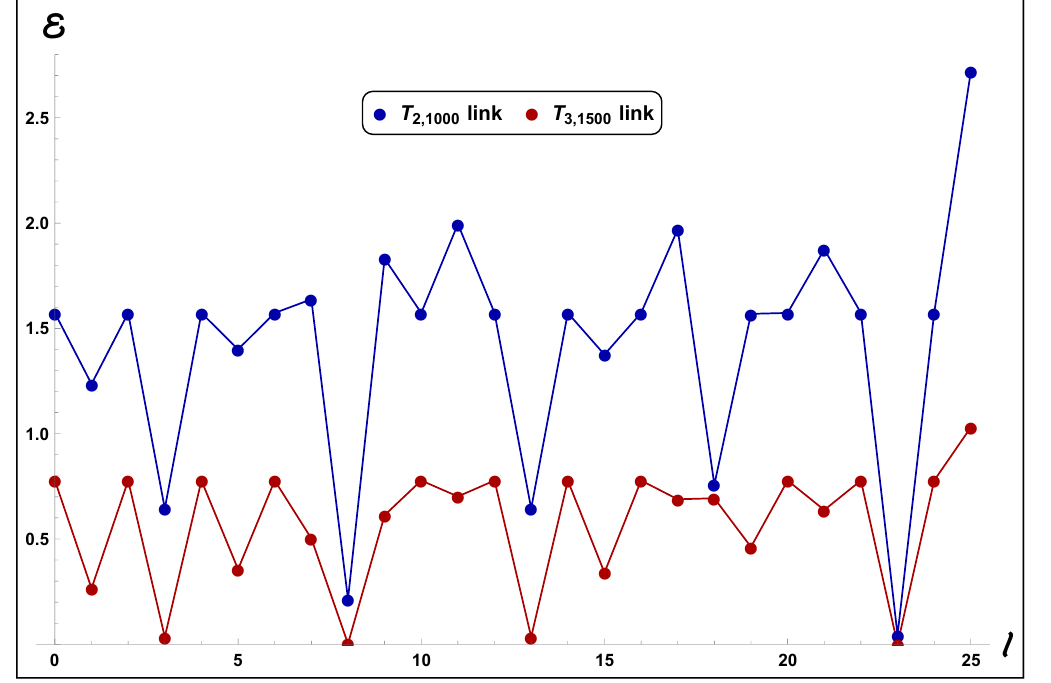
Figure 13. The variation of the entanglement entropy with ‘ for large values of k and n . The two plots are respectively for T 2 , 2 n and T 3 , 3 n links with n = 500 and the value of k is given as k = 500 + ‘